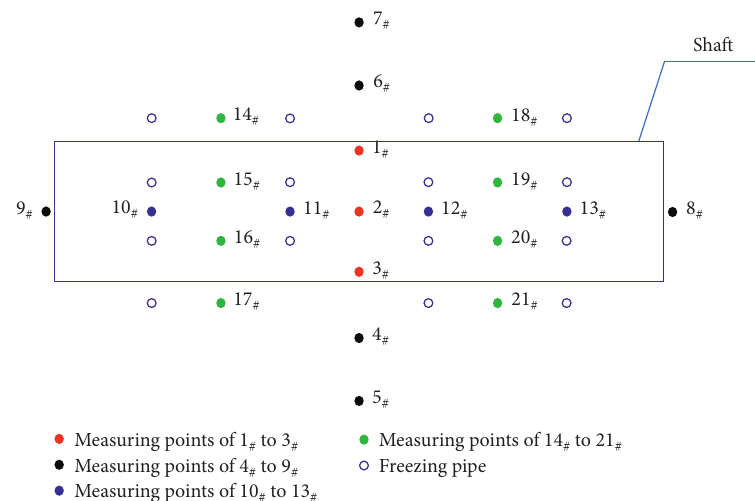
Figure 6: Schematic representation of the temperature measurement points layout.